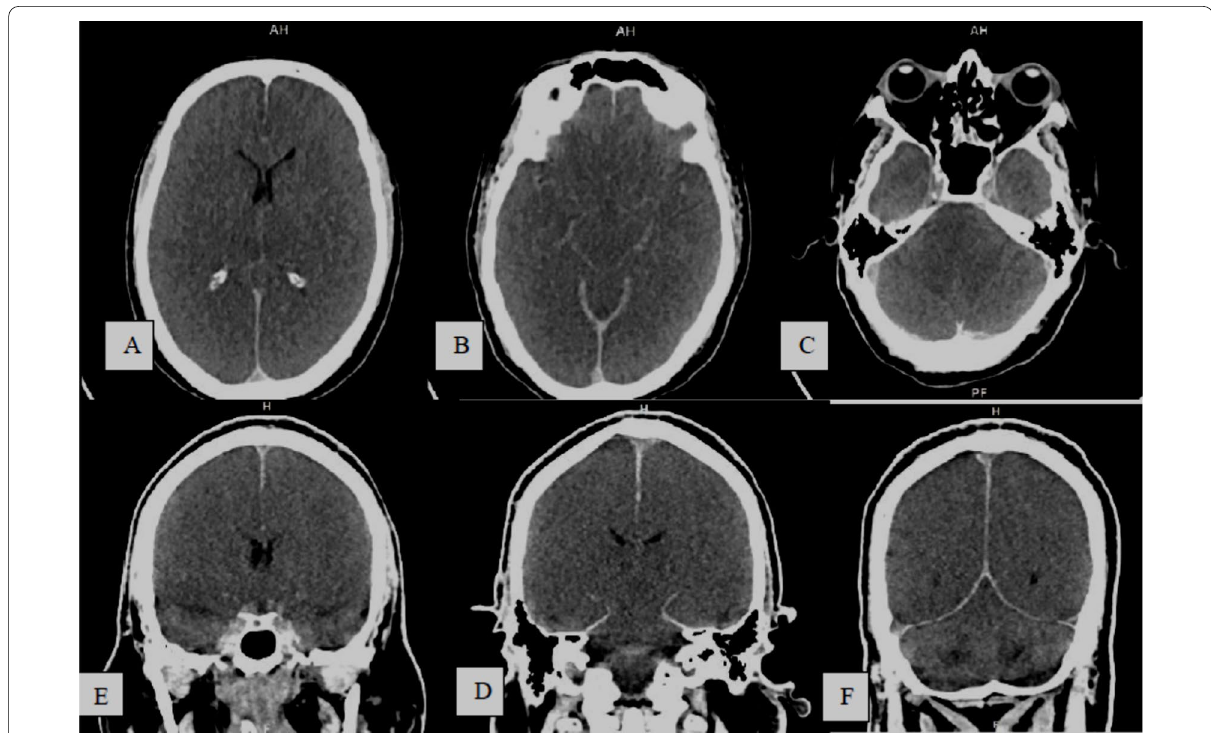
Fig. 5 60-year-old COVID-19 male patient with impaired level of consciousness, A – C serial axial CT brain study without contrast, D – F serial coronal reformatting images, showing poor gray/white matter differentiation with diffuse brain parenchyma hypodensity reflecting diffuse cerebral